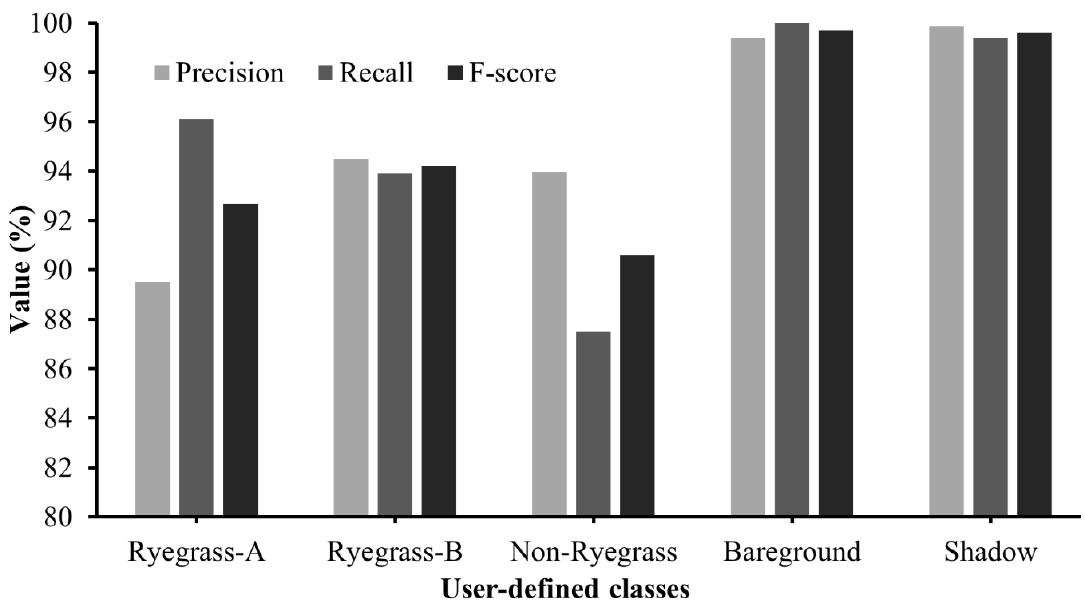
Figure 5. Accuracy statistics for the best model used for detecting Italian ryegrass in wheat, which combined color transformed features with vegetation indices. Precision, recall, and F-score values (%) (Y-axis) are shown for each of the five user defined classes (X-axis).